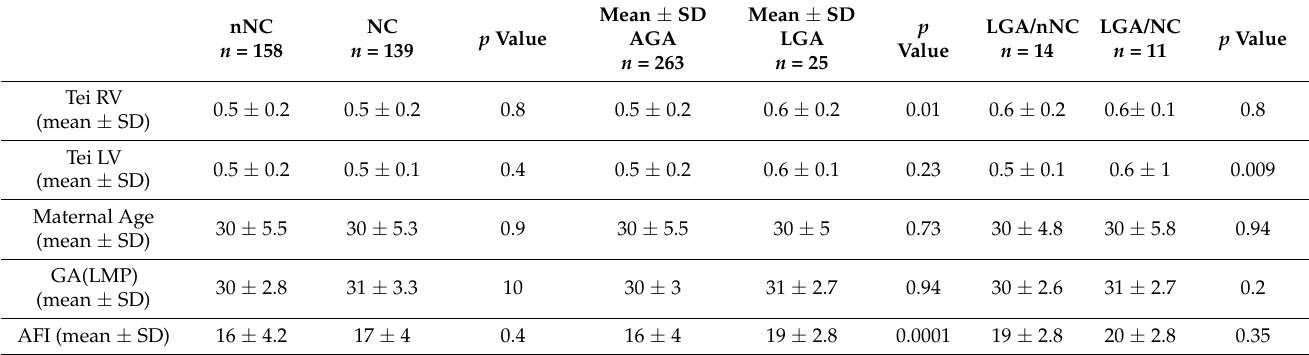
Table 1. Characteristics of groups of patients with: NC (loop 1) ( n = 139) vs. nNC (loop 0) ( n = 158), (t-Welch test). Characteristics of groups of patients with AGA ( n = 263) and LGA ( n = 25), (t-Welch test). The subgroup of fetuses with LGA: with NC ( n = 14) and with no umbilical cord collision—nNC ( n = 11) and significant statistical difference in TEI LV; p value ≤ 0.009 (t-Welch